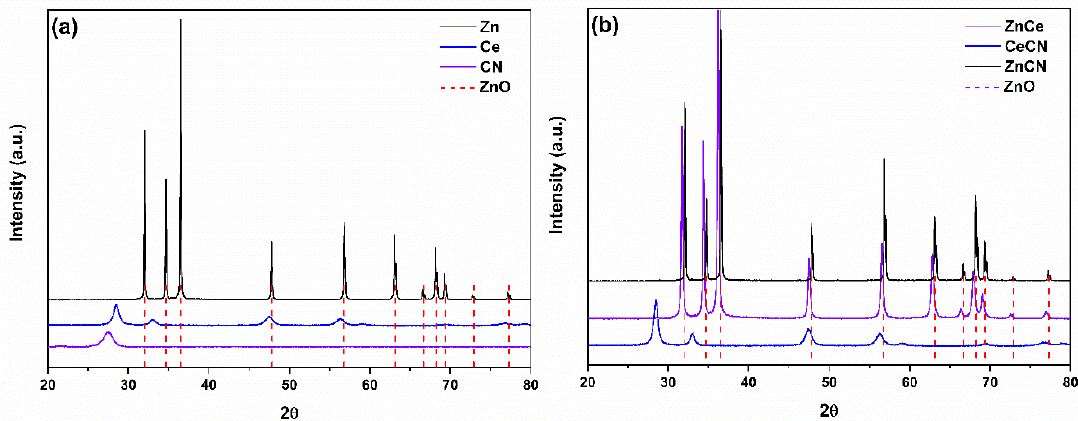
Figure 3. Diffraction patterns of ( a ) pure and ( b ) binary compounds. ZnCN has diffractions corresponding to the hexagonal structure of zinc oxide. The presence of a graphite phase is discarded; it is probably in an amorphous form. The diffraction intensity is lower and broader, compared to Zn. These two characteristics are typical of the formation of ZnO/C [54]. This product shows excellent activity in the visible region [55]. On the other hand, the CeCN sample exhibited the cubic structure of cerium oxide. The mixture of urea and cerium nitrate is explosive in the presence of an energy source [56]. Urea in contact with cerium nitrate decomposes to biuret and ammonia, then to isocyanic acid ((HNCO) 3 ) at high temperatures [57]. On the other hand, urea promotes the nucleation of cerium oxide at low temperatures [58]. Therefore, the CeCN sample